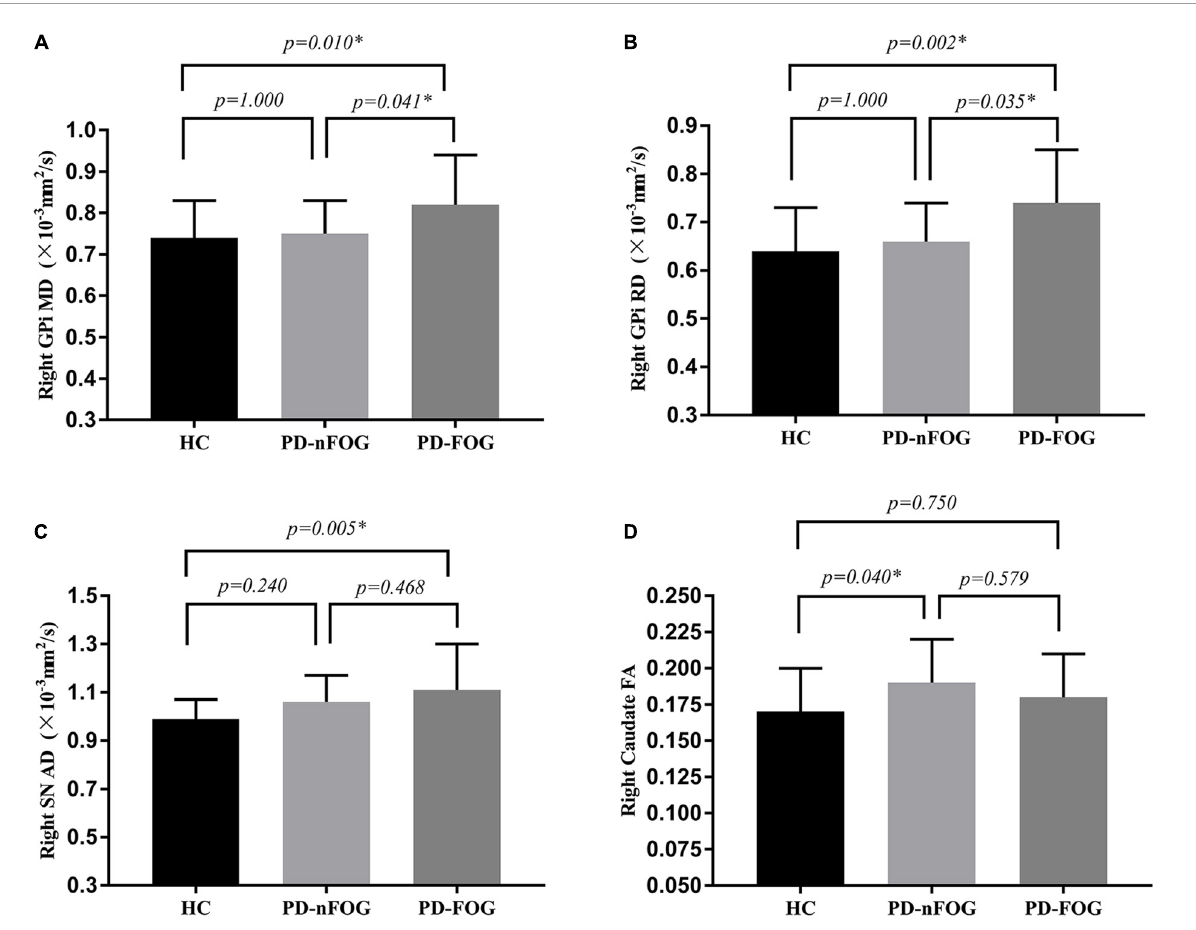
FIGURE1 Comparison of DTI Measures across groups. (A) MD value of the right GPi; (B) RD value of the right GPi; (C) AD value of the right SN; (D) FA value of the right caudate. * p < 0.05. MD, Mean Diffusivity; RD, radial diffusivity; AD, axial diffusion; FA, fractional anisotropy; GPi, globus pallidus internus; SN, substantia nigra; HC, healthy controls; PD-nFOG, PD patients without FOG; PD-FOG, PD patients with